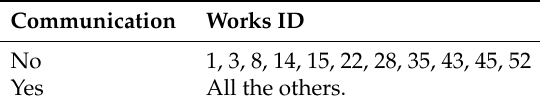
Table 5. Presence of communication costs.